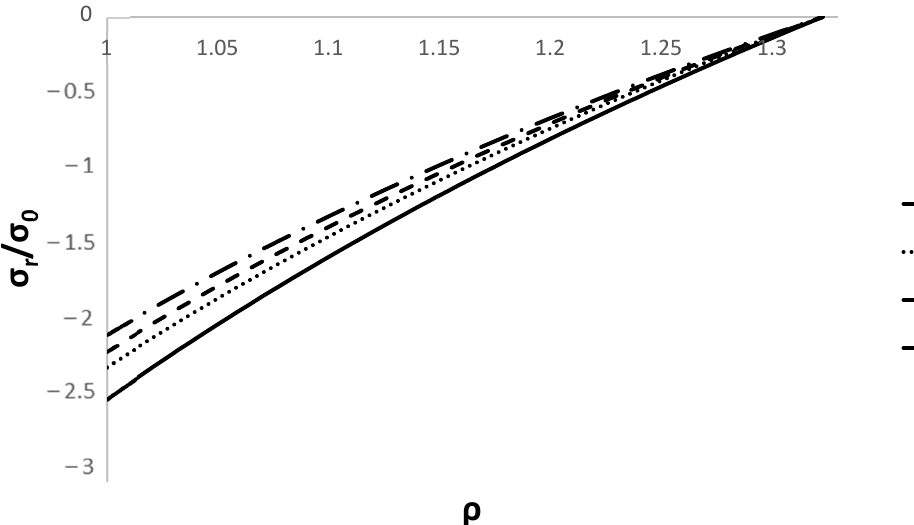
Figure 2. Variation in p with α at several values of ν .